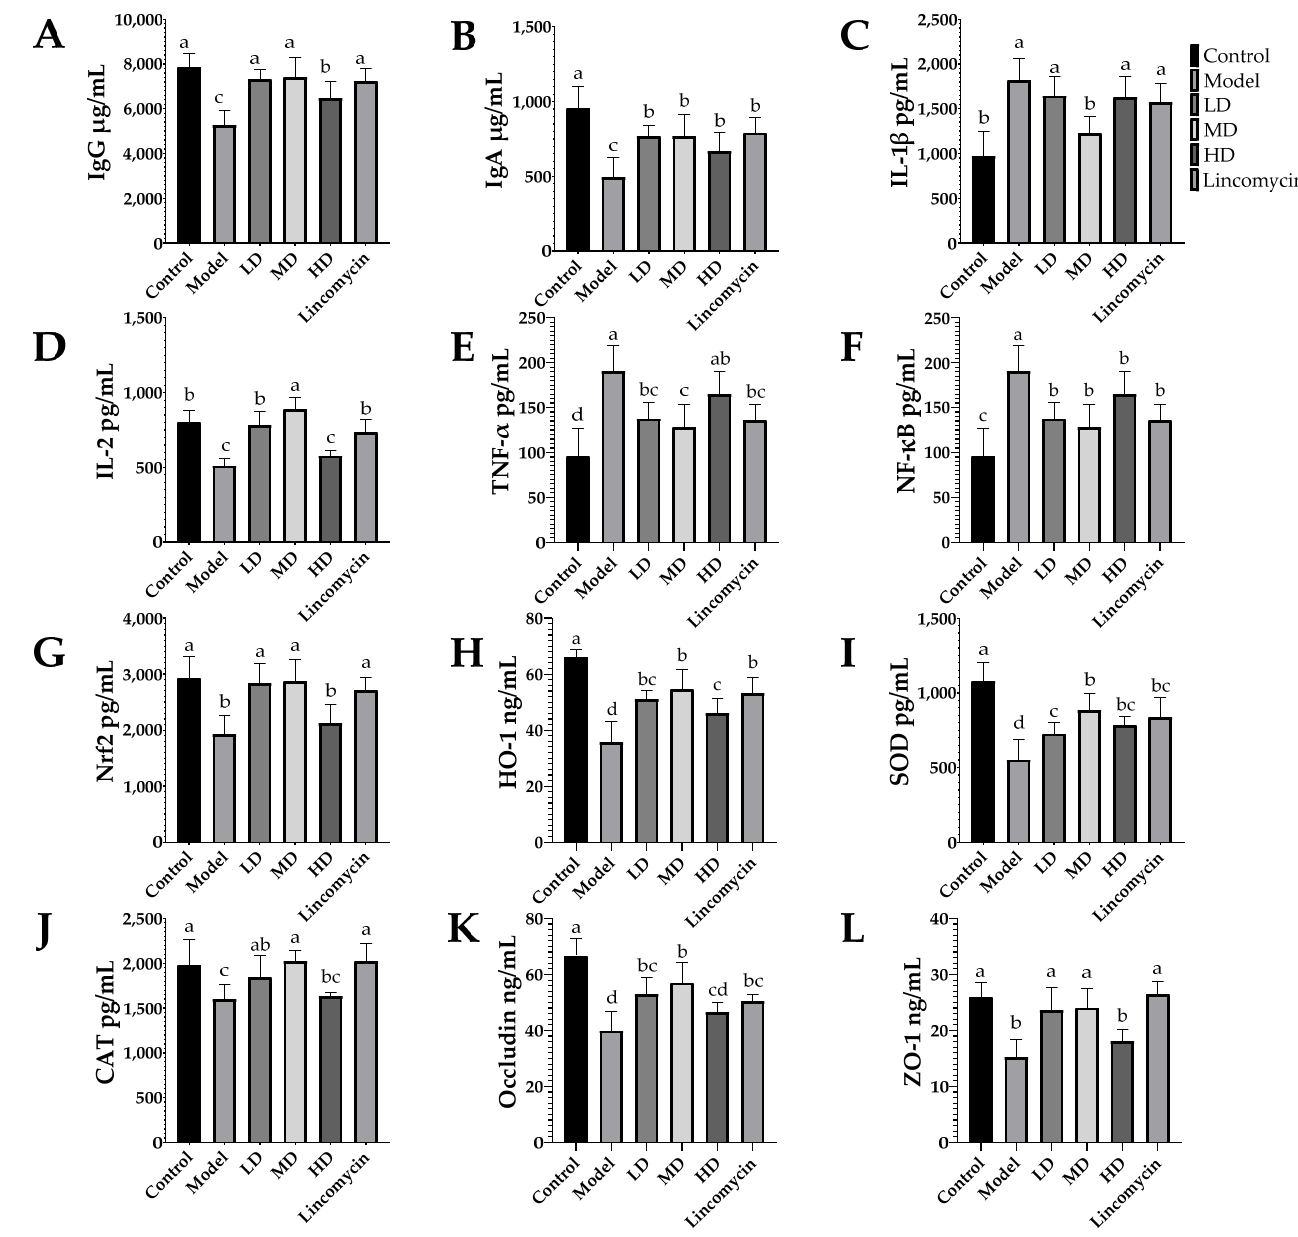
Figure 7. Concentrations of various immunoglobulins, inflammatory factors, and antioxidant factors in jejunal tissue. ( A ) Immunoglobulin G (IgG); ( B ) immunoglobulin A (IgA); ( C ) interleukin 1 beta (IL-1 β ); ( D ) interleukin 2 (IL-2); ( E ) tumor necrosis factor alpha (TNF- α ); ( F ) nuclear factor kappa B (NF- κ B); ( G ) nuclear factor erythroid 2-related factor 2 (Nrf-2); ( H ) heme oxygenase 1 (HO-1); ( I ) catalase (CAT); ( J ) superoxide dismutase (SOD); ( K ) occludin; ( L ) zonula occludens 1 (ZO-1). Values with the same superscript letters in the same line were not significantly different ( p > 0.05); values with different letters were significantly different ( p < 0.05).